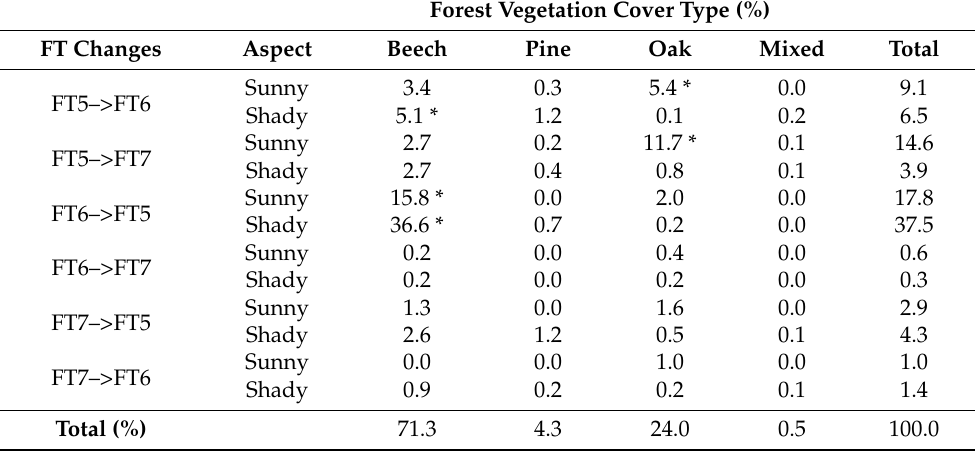
Table 7. Changes among structural stand and fuel types (FT5: forest without understory; FT6: forest with shrubs; FT7: forest with vertical continuity), forest vegetation cover types (beech, oak, pine and mixed deciduous forest) and aspect (sunny and shady). Statistically significant frequencies ( p < 0.05) have been identified with an asterisk (*). Forest Vegetation Cover Type (%) FT Changes Aspect Beech Pine Oak Mixed